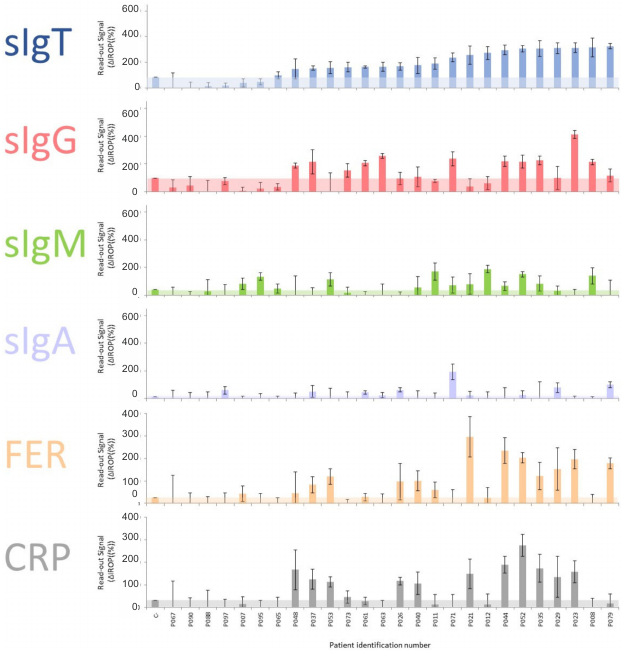
Figure 4. Results of the biomarkers measured in samples from patients with Moderate symptoms. The cut-off for each marker is shown in colored shading. Abbreviations: total specific Immunoglobulins (sIgT), specific Immunoglobulins G (sIgG), specific Immunoglobulins M (sIgM), specific Immunoglob- ulins A (sIgA), together with Ferritin (FER), C Reactive Protein (CRP) and ∆ IROP (%) (Increased Relative Optical Power.